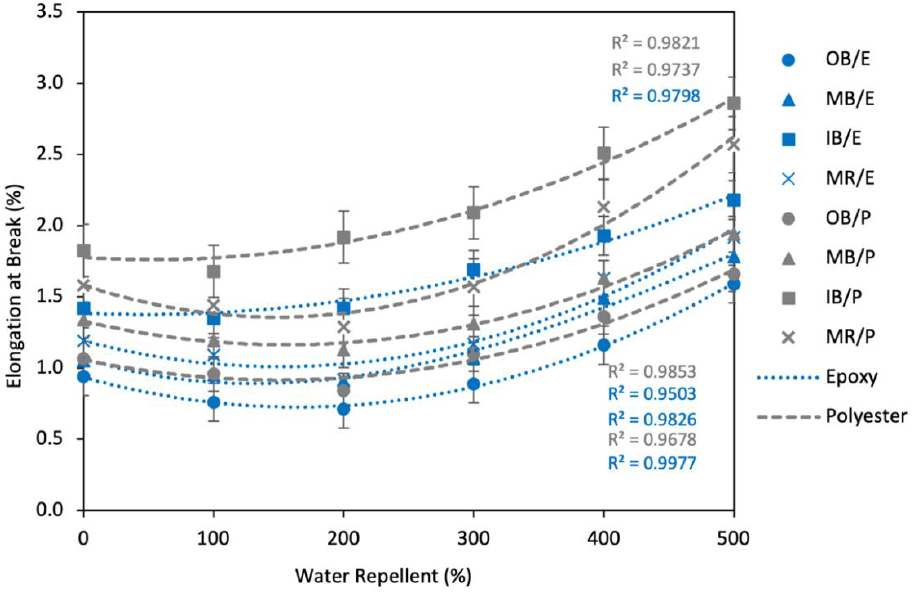
Figure 17. Effect of gamma radiation on elongation at break (%) of the composites.